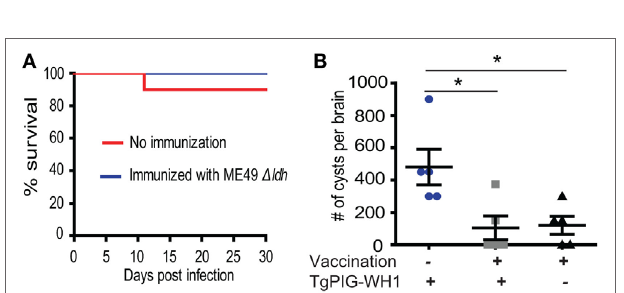
FigUre 2 | Δ ldh parasite immunization protected mice from Toxoplasma gondii tachyzoites infection. ICR mice were pre-immunized with 10 4 tachyzoites of the ME49 Δ ldh mutant. (a–c) 30 days post-immunization, they were challenged with 10 4 tachyzoites of the ME49 (a) , VEG (B) , or C7719 (c) strains (10 mice for each strain) by intraperitoneal injection and their survival was monitored for another 30 days. (D–F) 75 days post-immunization, 10 4 tachyzoites of the RH Δ hxgprt (D) , ME49 (e) , C7719 (F) strains were used to challenge the mice and their survival was monitored for another 30 days. (g,h) 125 days post-immunization, 10 4 tachyzoites of the ME49 (g) , VEG (h) strains were used to challenge the mice and their survival was monitored for another 30 days. Non-immunized mice were included as control. *** p < 0.001, Gehan–Breslow–Wilcoxon